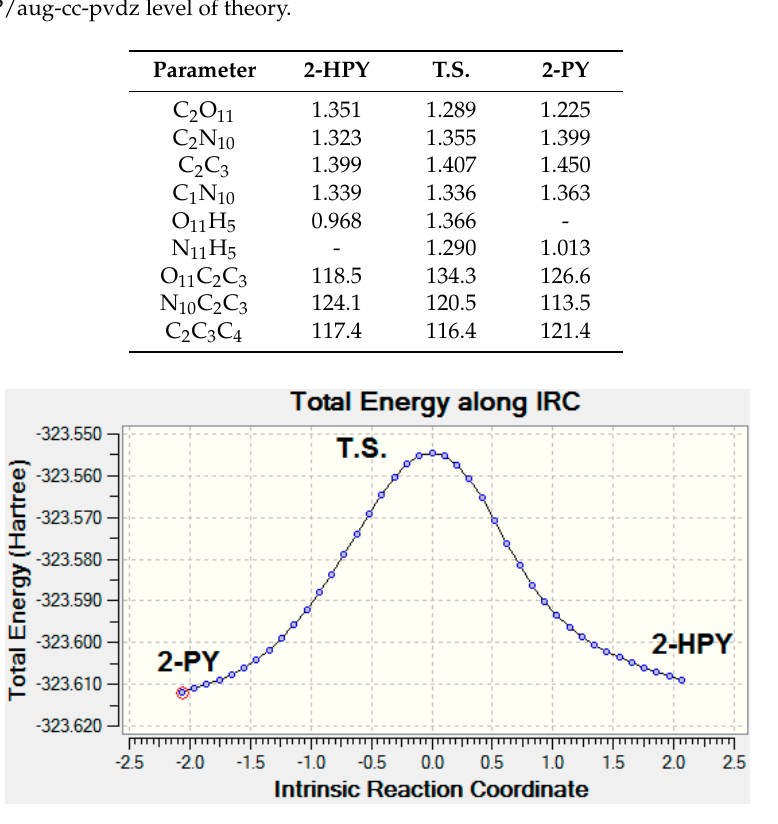
Figure 2. Intrinsic reaction coordinate (IRC) of the tautomerization of 2-HPYand 2-PY through the transition states (T.S.) which were obtained by using B3LYP/6-311++G** level of theory.